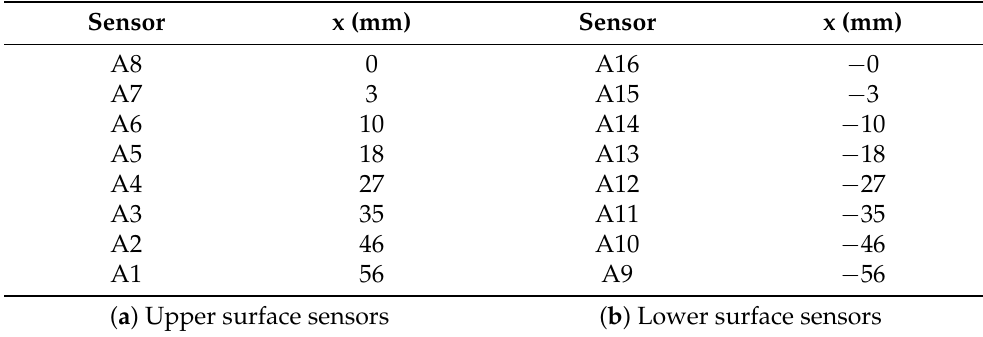
Table 4. Chordwise distance of each sensor from the leading edge.